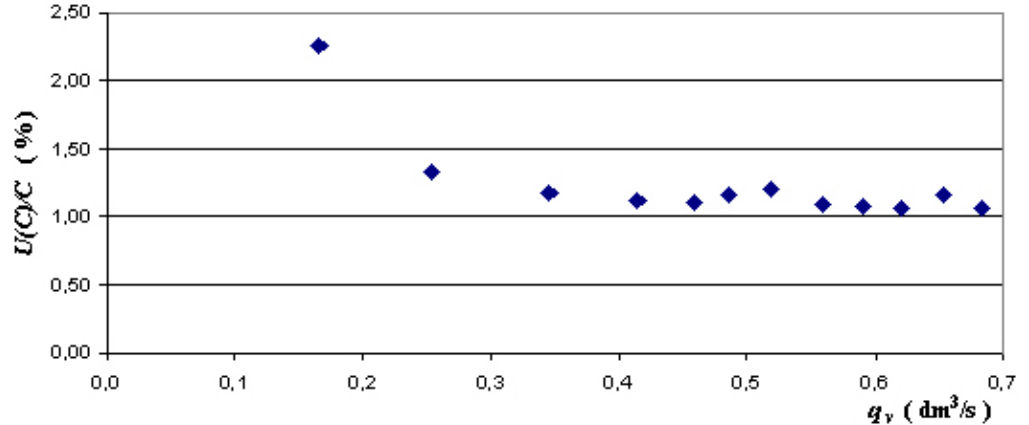
Figure 4. Distribution of relative expanded uncertainty of flow ratio U ( C ) / C dependent upon volume stream q v .